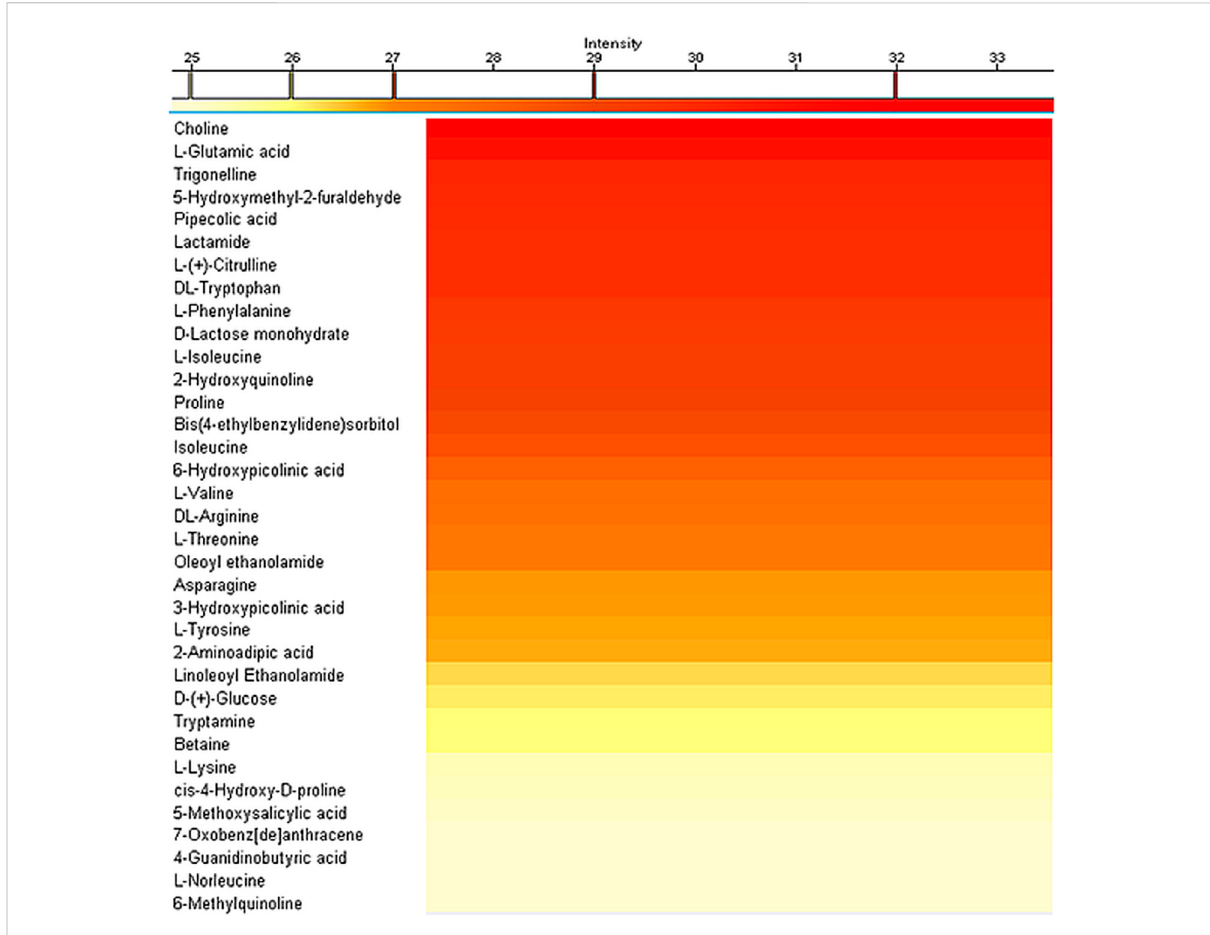
FIGURE 1 Massspectrometry analysisofthehazelnutextractsshowingtherelativeamountofthecompoundsdetectedbyusingaC18columninpositive ion